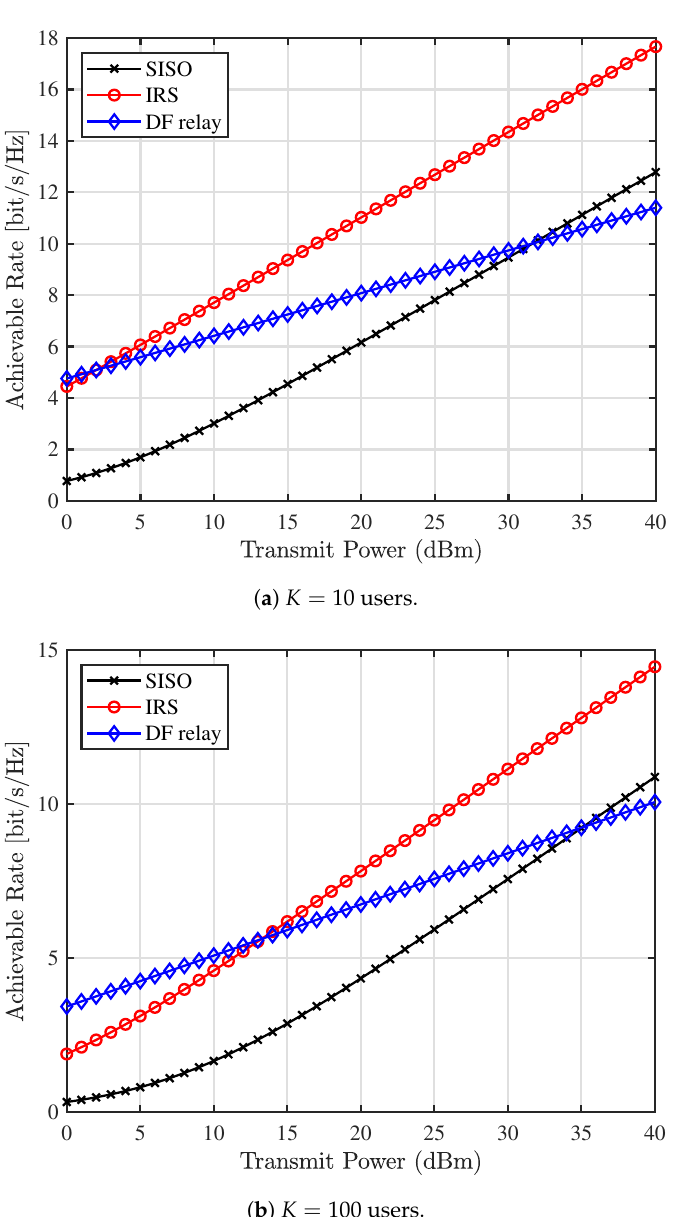
Figure 7. The achievable rate based on varying transmit power with different numbers of users. Figure 8 shows the required transmit power with respect to distance ( d 1 ) for two data rate scenarios ¯ R = 6 bit/s/Hz and ¯ R = 8 bit/s/Hz. Here, the number of users K = 100. It can be seen from the figure that, under low data rate requirements ( ¯ R = 6 bit/s/Hz), the DF relay transmitted the least power among the three scenarios. However, when the data rate requirement increased to ¯ R = 8 bit/s/Hz, the IRS- aided frameworks with 150 and 200 elements outperformed the rest. Accordingly, higher QoS requirements can be satisfied in wireless networks by using IRS panels, where the number of elements are greater than